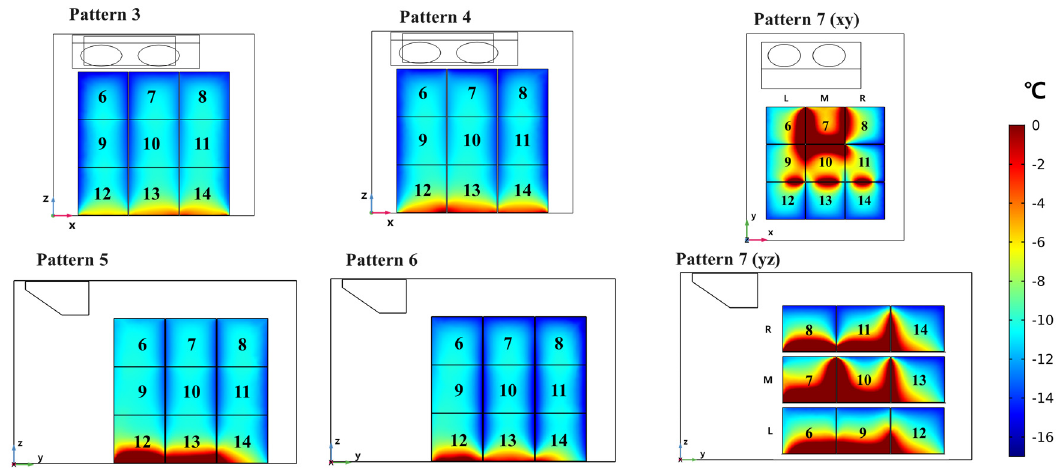
Figure 12. Predicted temperature distribution in boxes with different loading patterns. Table 5. The average lowest temperature values of boxes temperature measured over 1 h.